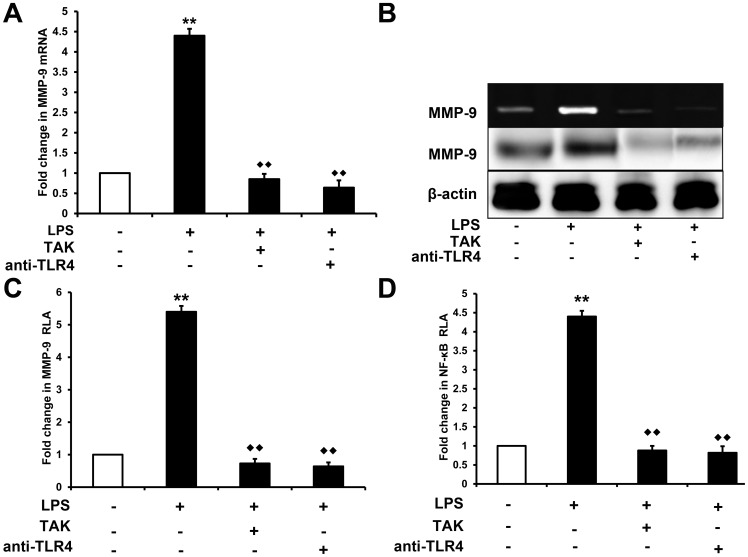
TLR4 mediates LPS-induced NF-κB/MMP-9.
A: FLSs were pretreated with TAK (5 µM) and anti-TLR4 (1 µg/mL) for 24 h and then stimulated with 1 µg/mL of LPS for 24 h. MMP-9 mRNA expression in cells was analyzed by qRT-PCR. GAPDH was used as an internal control. The histogram shows the mRNA levels from three independent experiments. B: FLSs were pretreated with TAK (5 µM) and anti-TLR4 (1 µg/mL) for 24 h and then stimulated with 1 µg/mL of LPS. After 24 h, conditioned media was collected and gelatin zymography or western blotting was performed. C and D: FLSs were transfected with pGL2-MMP-9WT or pGL2-NF-kB reporter plasmids and then cultured with TAK (5 µM) and anti-TLR4 (1 µg/mL) and/or LPS (1 µg/mL) for 24 h. Luciferase activity in the cell extracts was determined. The data are presented as mean ± SD of triplicate experiments. **
P<0.01 versus normal control group, ⧫
P<0.05, ⧫⧫
P<0.01 versus LPS alone-treated group.